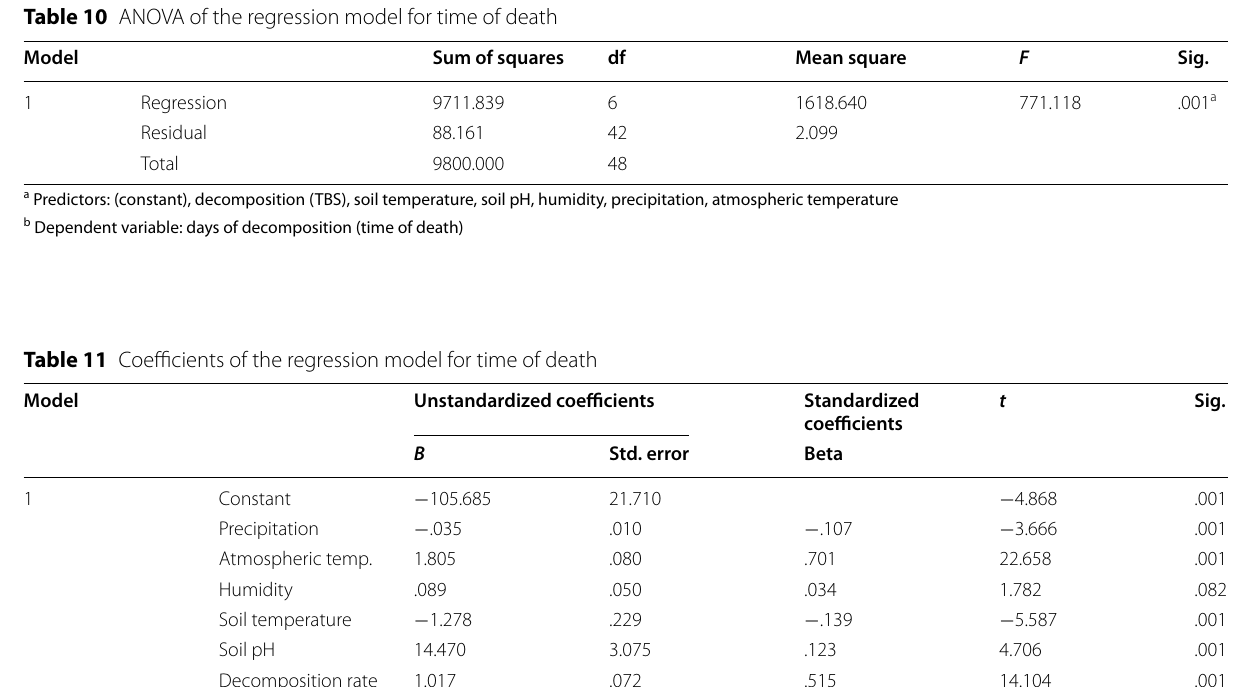
Variable: days of decomposition (time of death)